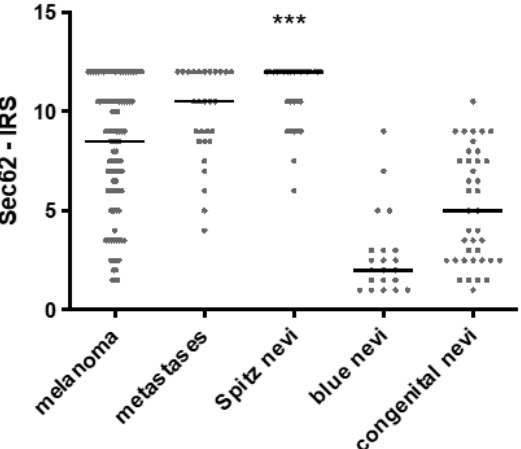
Figure 3. SEC62 expression in different melanoma subtypes. Sec62-IRS delineated for primary melanoma, melanoma metastases, Spitz nevi, blue nevi, and congenital nevi. Every dot represents one patient and the median is indicated by a line. Statistics: one-way ANOVA test; ***— p < 0.001.